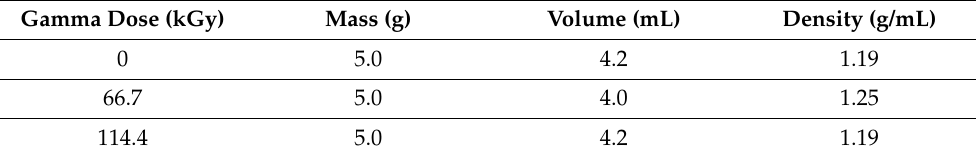
Table 4. Density of PLA 4043D resins irradiated with 0, 66.7 and 114.4 kGy gamma doses.